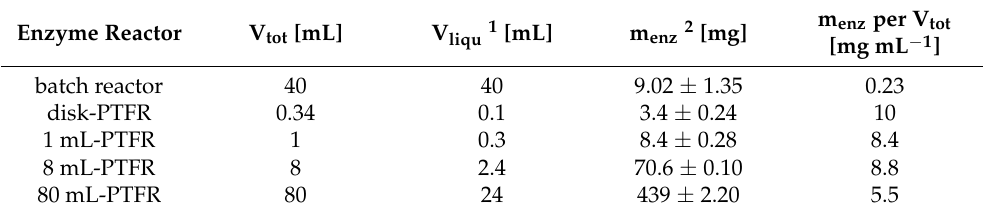
m enz per V tot [mg mL − 1 ]